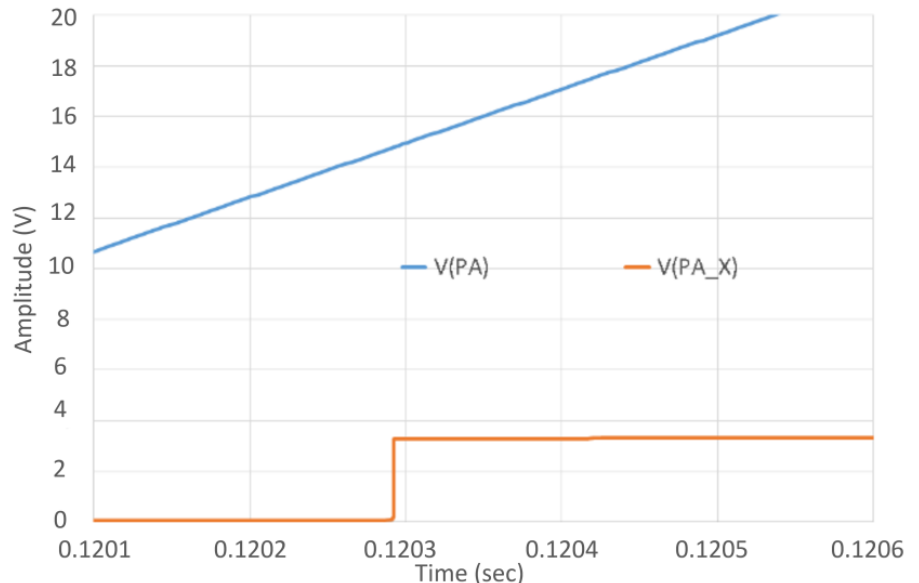
Figure 18. Simulation results of the line frequency circuit.